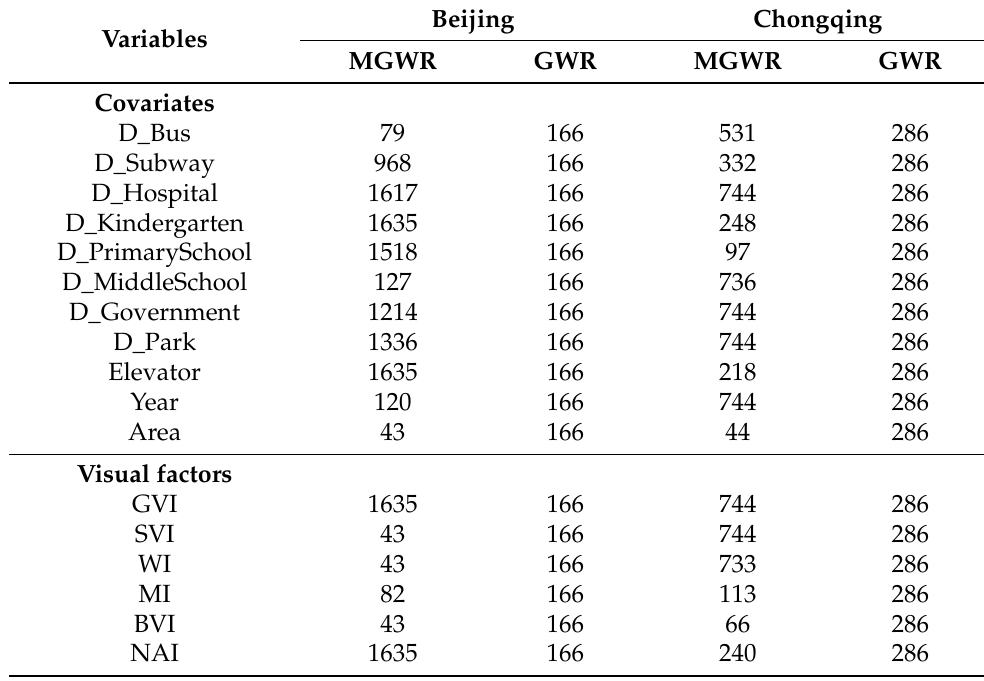
Table 5. Comparison of parameter bandwidth between MGWR and